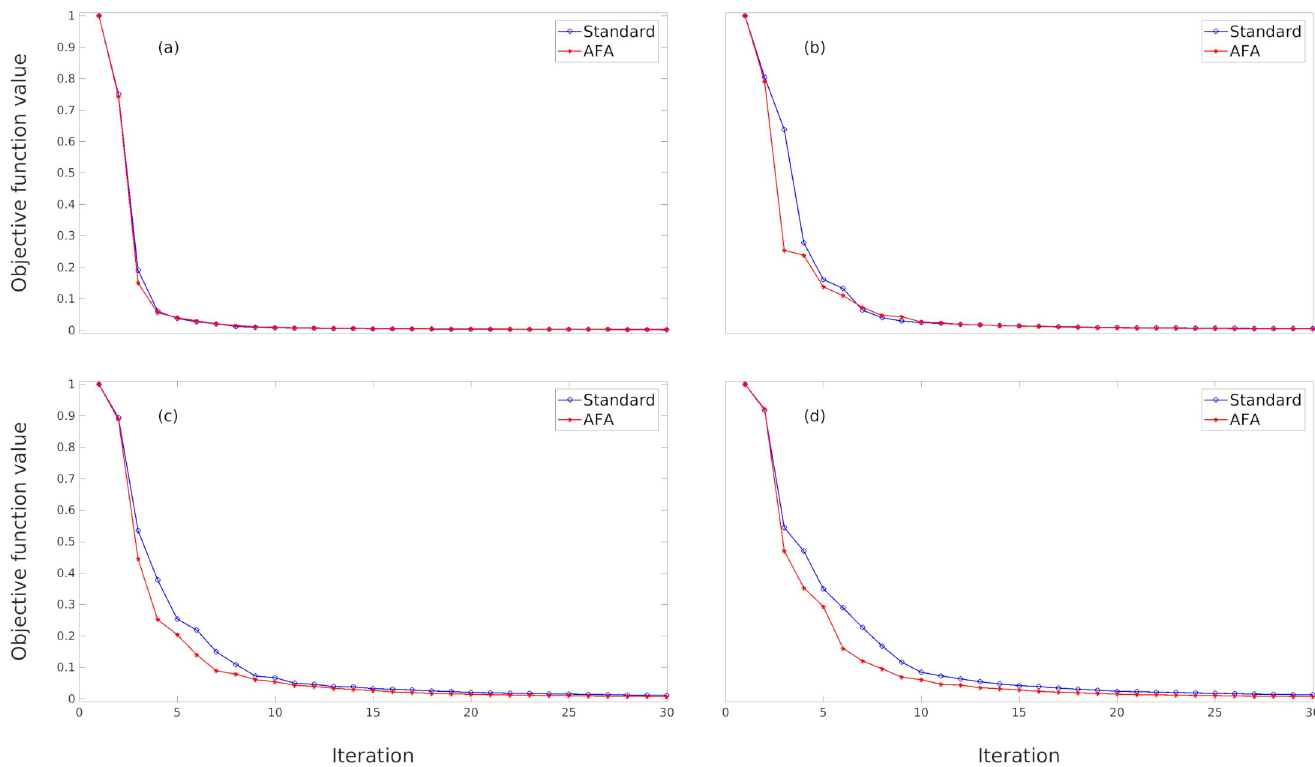
Fig 3. Measuring the convergence of the inverse method: The objective function. We compare the objective function of the conventional acquisition method with that of the AFA 4x4 method, that is, the schema of 4 low-pass and 4 high-pass sensors. We illustrate the convergence for the following frequencies: (a) 3 Hz , (b) 7 Hz , (c) 10.5 Hz , and (d) 13 Hz